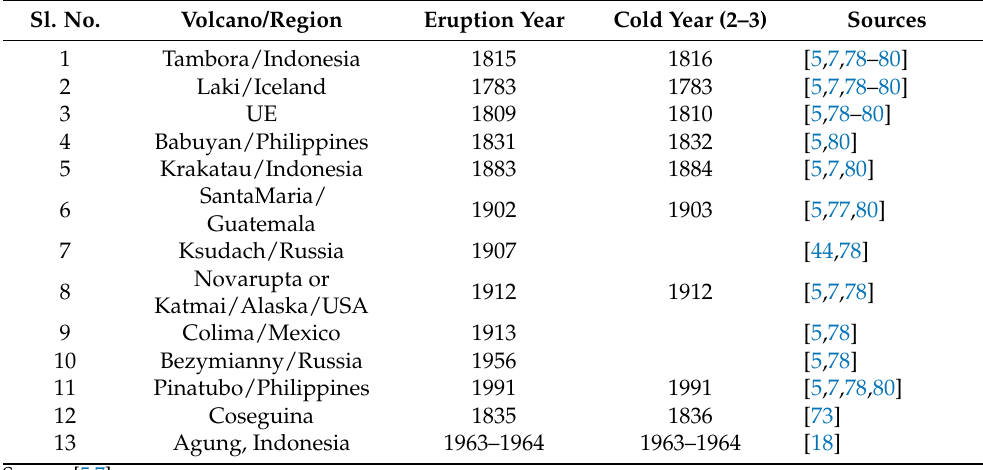
Table A1. Volcanic eruptions and volcanic forced cold year prints in tree ring index-based